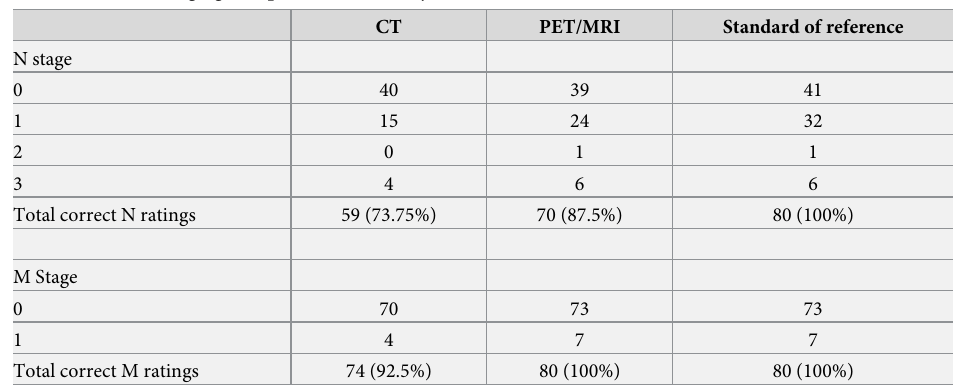
Table 1. N and M staging on a patient-based analysis.